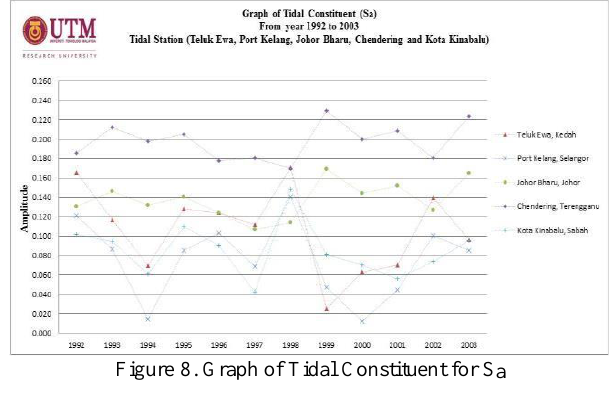
Figure 6. Graph of Tidal Constituent for K1 Figure 6 above show that the graph of tidal constituent for K1. The pattern for this tidal constituent is constant and does not have a big changing of amplitude. It can be stated that there are no effect of El-Nino and La-Nina on this tidal constituent.